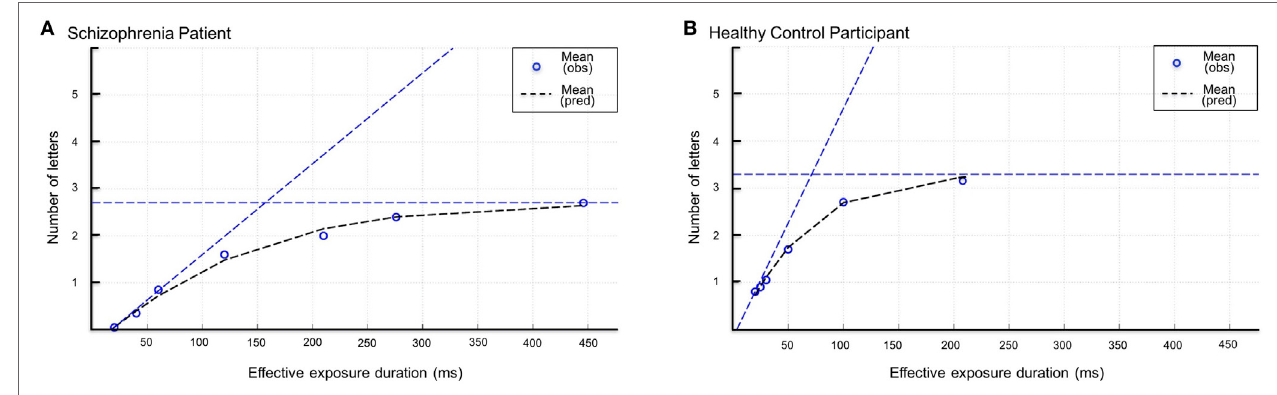
FiGUrE 3 | Whole-report performance of a representative schizophrenia patient (a) and a healthy control participant (B) . Mean number of correct letter reports as a function of exposure duration. Circles represent observed values ( = obs), dashed lines represent the best fits of the observed scores by the applied model (pred = predicted). The estimate of visual short-term memory capacity K and processing speed C is indicated by the horizontal and diagonal dashed lines,